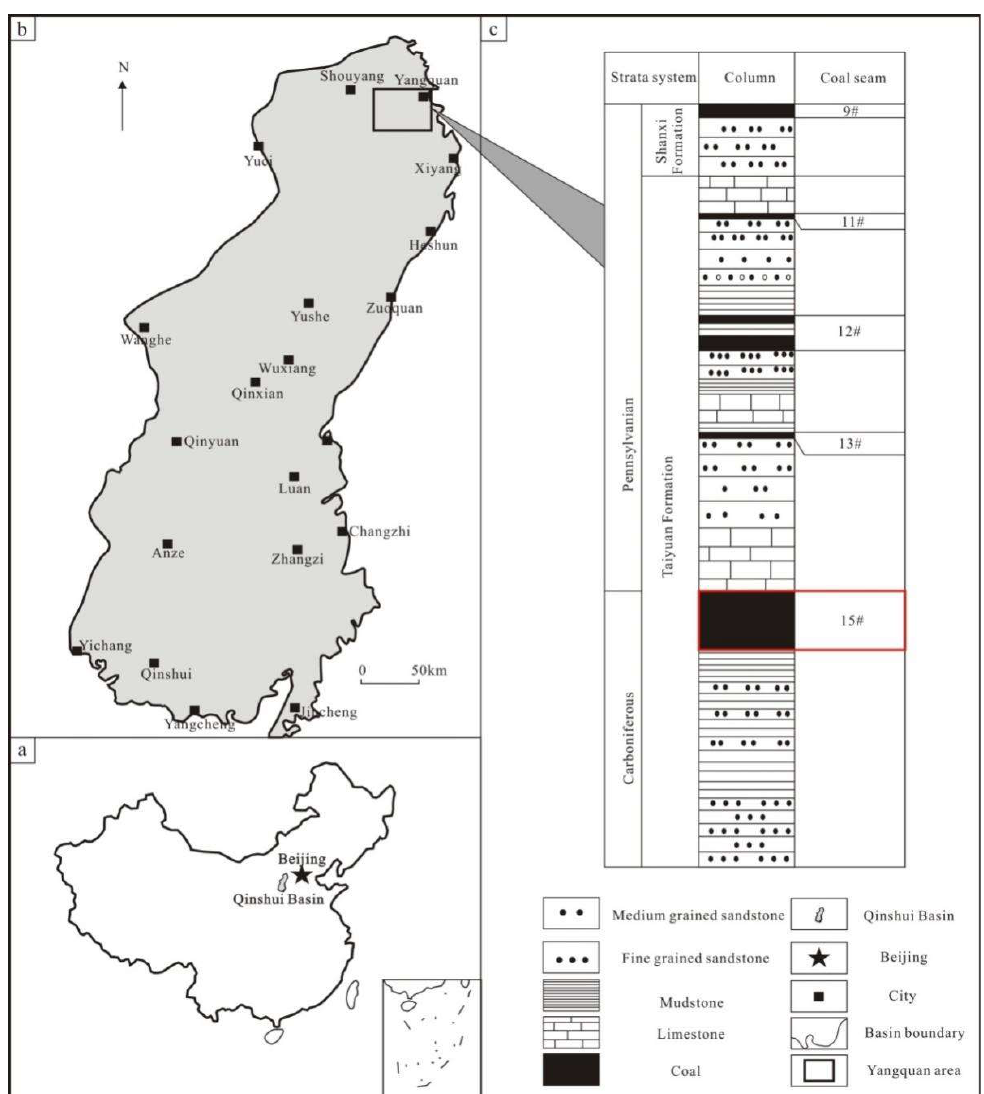
Figure 1. The location of the Yangyuan Area and stratigraphic column of the Taiyuan Formation in the Qinshui Basin, China. ( a , b ) The geographical location of the research area; ( c ) Lithological column and coal seams of the Taiyuan Formation in the study area.